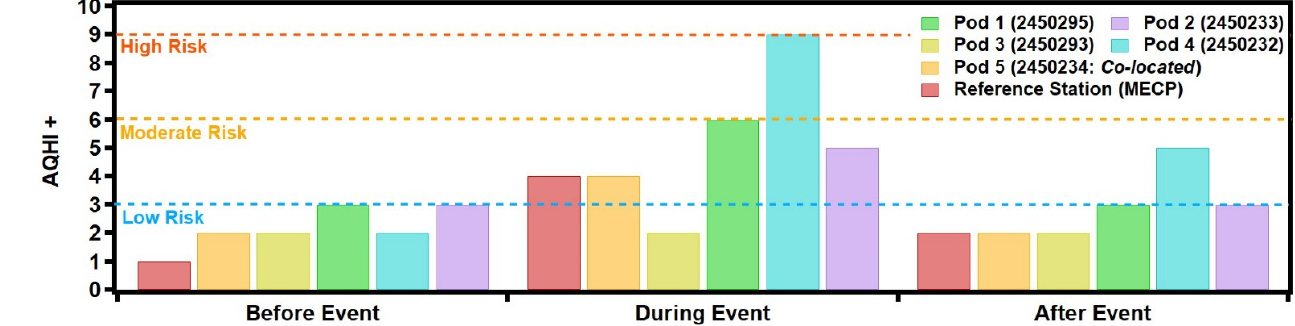
Figure 8. AQHI+ values captured by the sensor pods in the multisensor pod network in relation to the AQHI+ values captured at the reference station. Results illustrate significantly larger readings for Pod 4 during the event period.